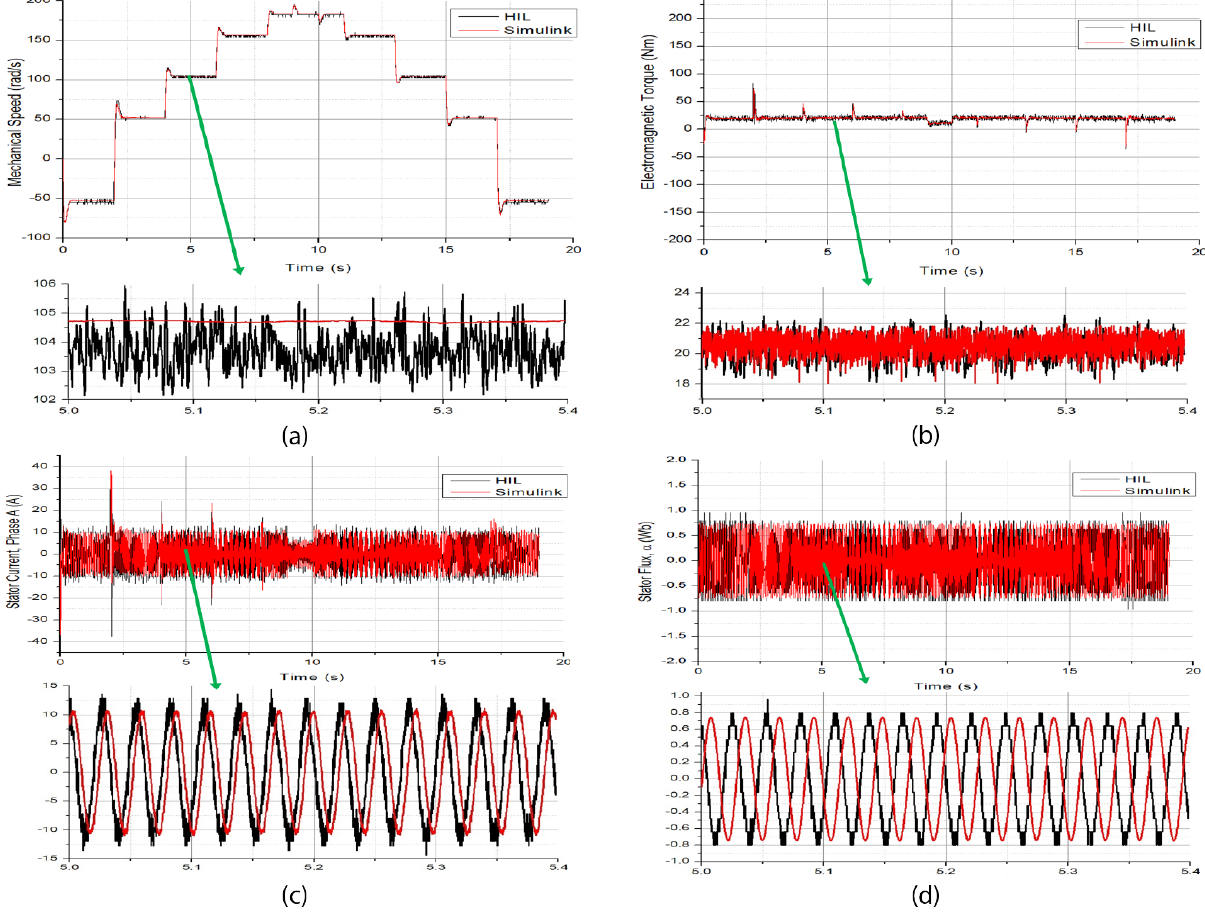
Figure 13. Numerical and practical results of the PTC variable speed controller: ( a ) speed; ( b ) torque; ( c ) stator current; and ( d ) stator